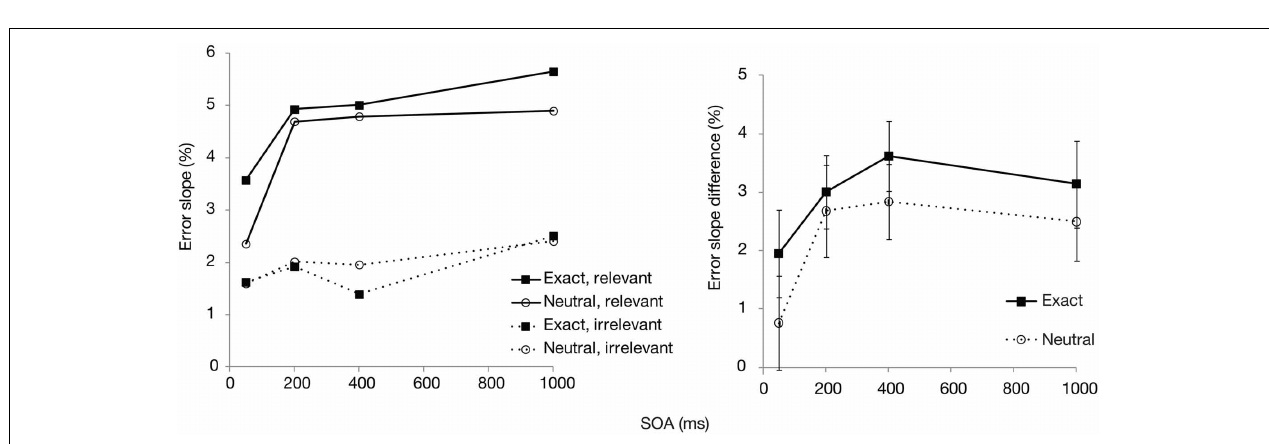
FIGURE 2 | Accuracyscoresfor Experiment 1, presented as afunction of postcuetypeand SOA. Left partof thefigure shows accuracyscores separately for therelevantandirrelevantsetsizes,rightpartshowsthetotalaveragesoverthesetsizes.Errorbarsshowthestandarderrorofthemeanhereandinotherfigures.